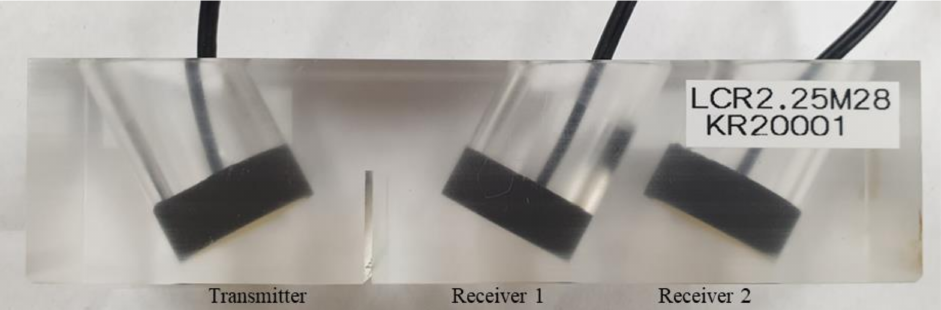
Figure 5. Photograph of a manufactured L CR wave probe.